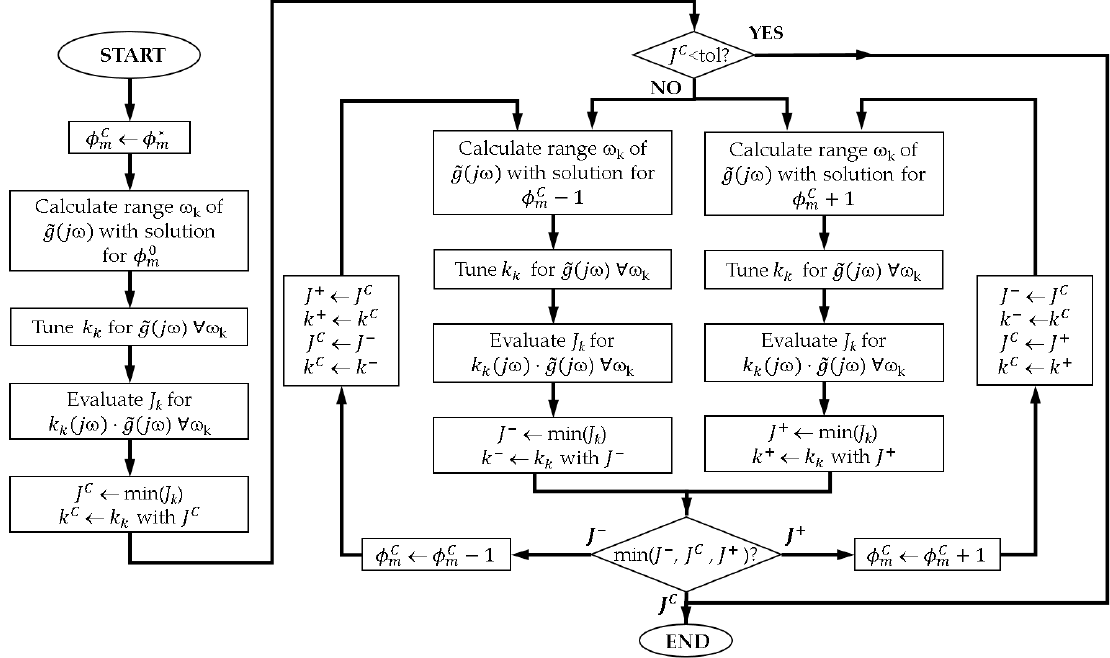
Figure 5. Flow diagram of the proposed single input single output (SISO) proportional-integral-derivative (PID) tuning algorithm for combined specification of phase margin ϕ m * and gain margin A m *.